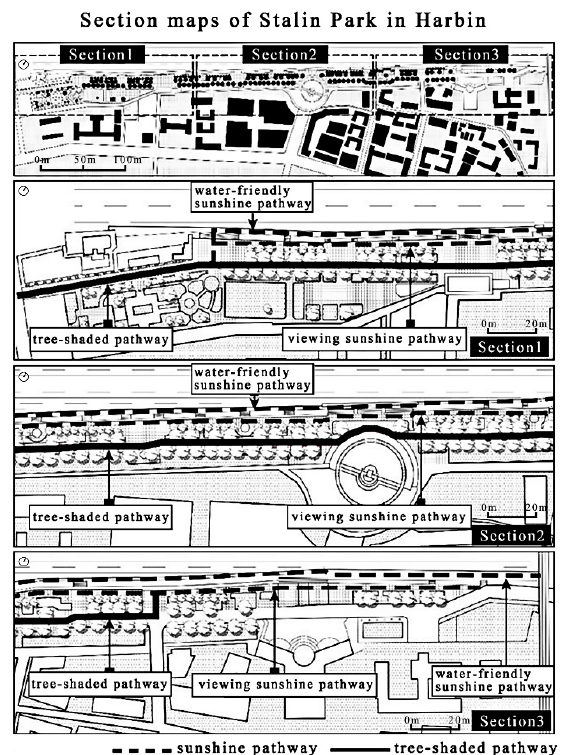
Figure 2. Section view of Stalin Park in Harbin.